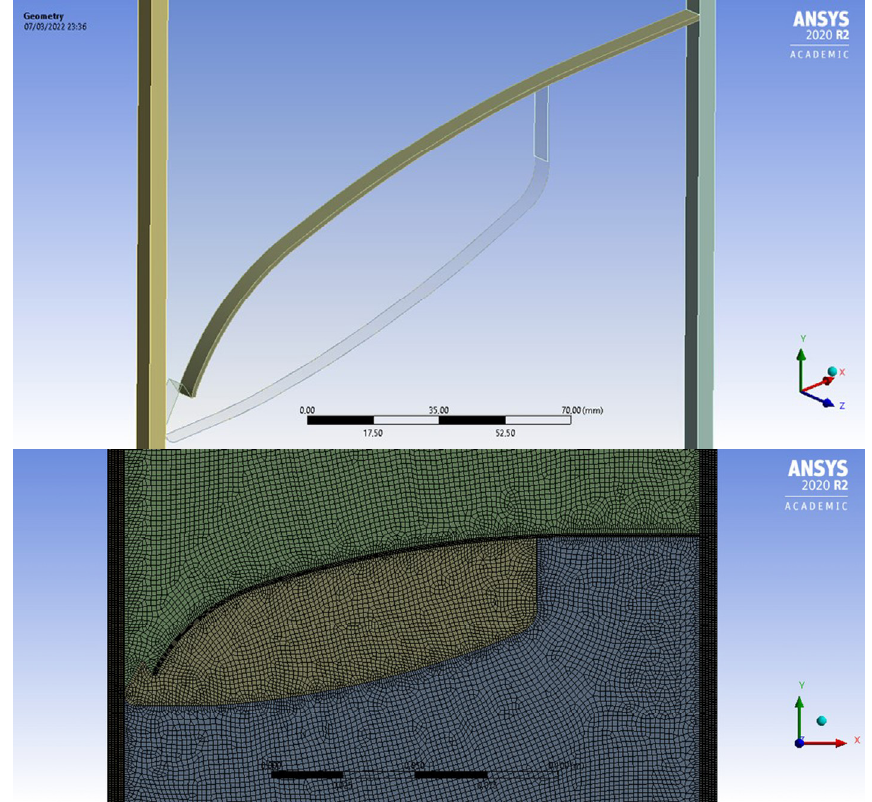
Figure 8. Details of the geometry ( top ) and mesh ( bottom ) for the CFD model.